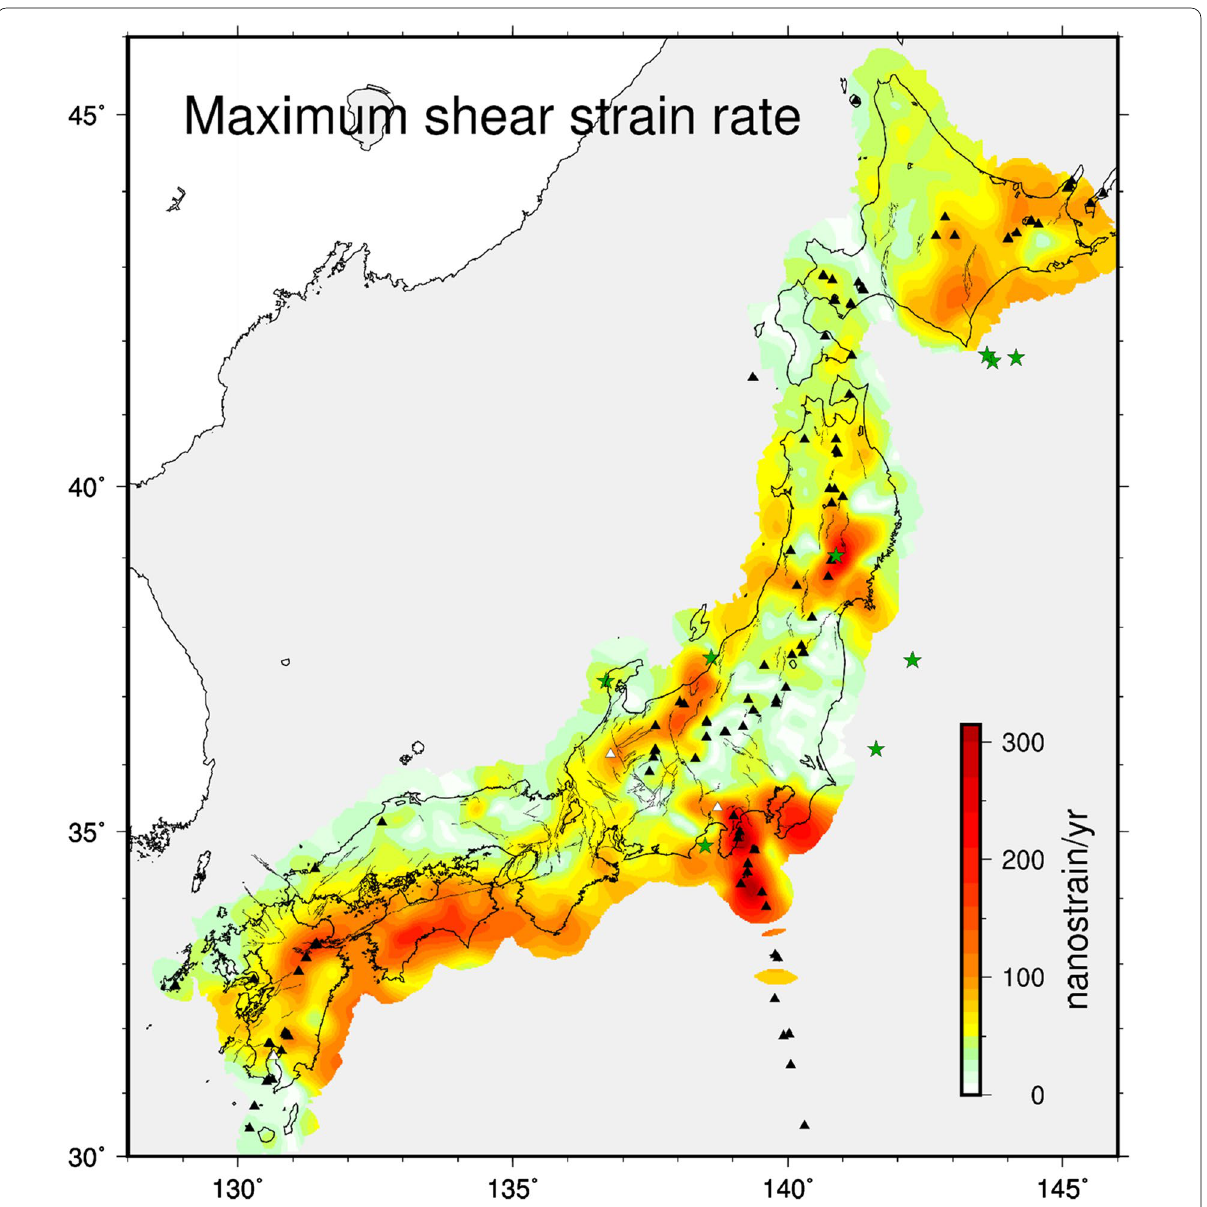
Fig. 17 The maximum shear-strain rate field estimated from the ABIC method with L = 20 km. Green stars represent the epicenters of earthquakes whose coordinate offsets are removed from GNSS data. Black lines represent surface traces of major active faults (Headquarters for Earthquake Research Promotion 2017). White triangles represent Mt. Fuji, Hakusan and Sakurajima, and black triangles represent other active volcanos (JMA